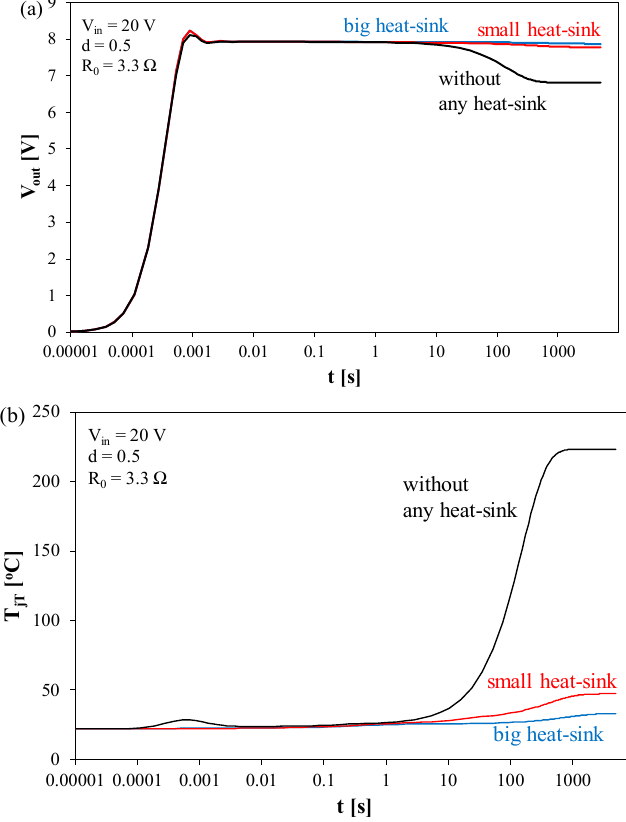
Figure 10. Computed waveforms of: ( a ) the buck converter output voltage at voltage V in of the form of a voltage step, ( b ) the transistor internal temperature.